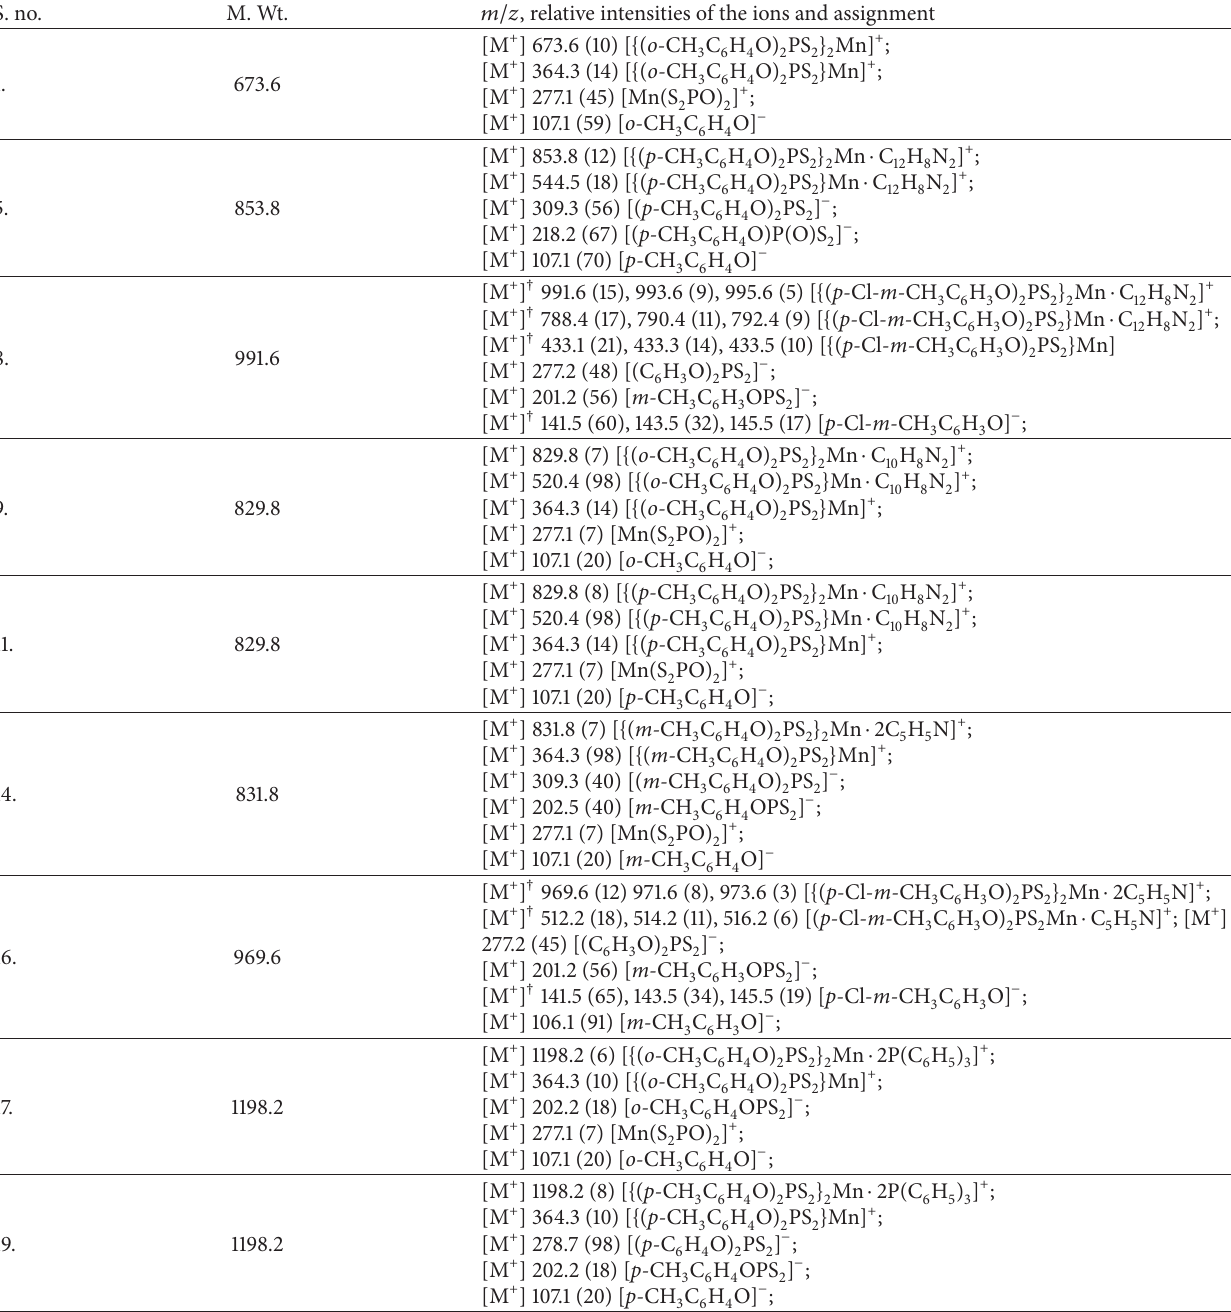
Table 3: Mass spectral data of the Mn(II) ditolyldithiophosphates.